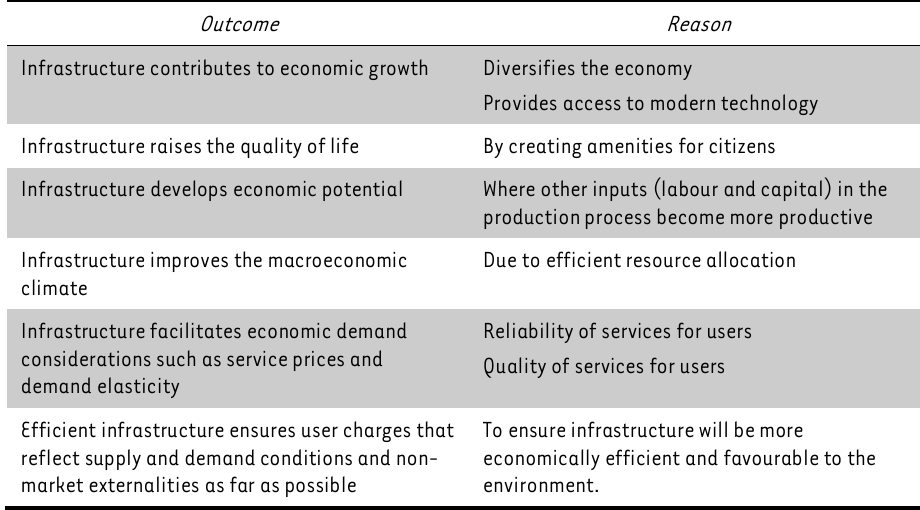
Benefits of infrastructure Outcome Reason Infrastructure contributes to economic growth Diversifies the economy Provides access to modern technology Infrastructure raises the quality of life By creating amenities for citizens Infrastructure develops economic potential Where other inputs (labour and capital) in the production process become more productive Infrastructure improves the macroeconomic Due to efficient resource allocation climate Infrastructure facilitates economic demand Reliability of services for users Quality of services for users demand elasticity To ensure infrastructure will be more economically efficient and favourable to the